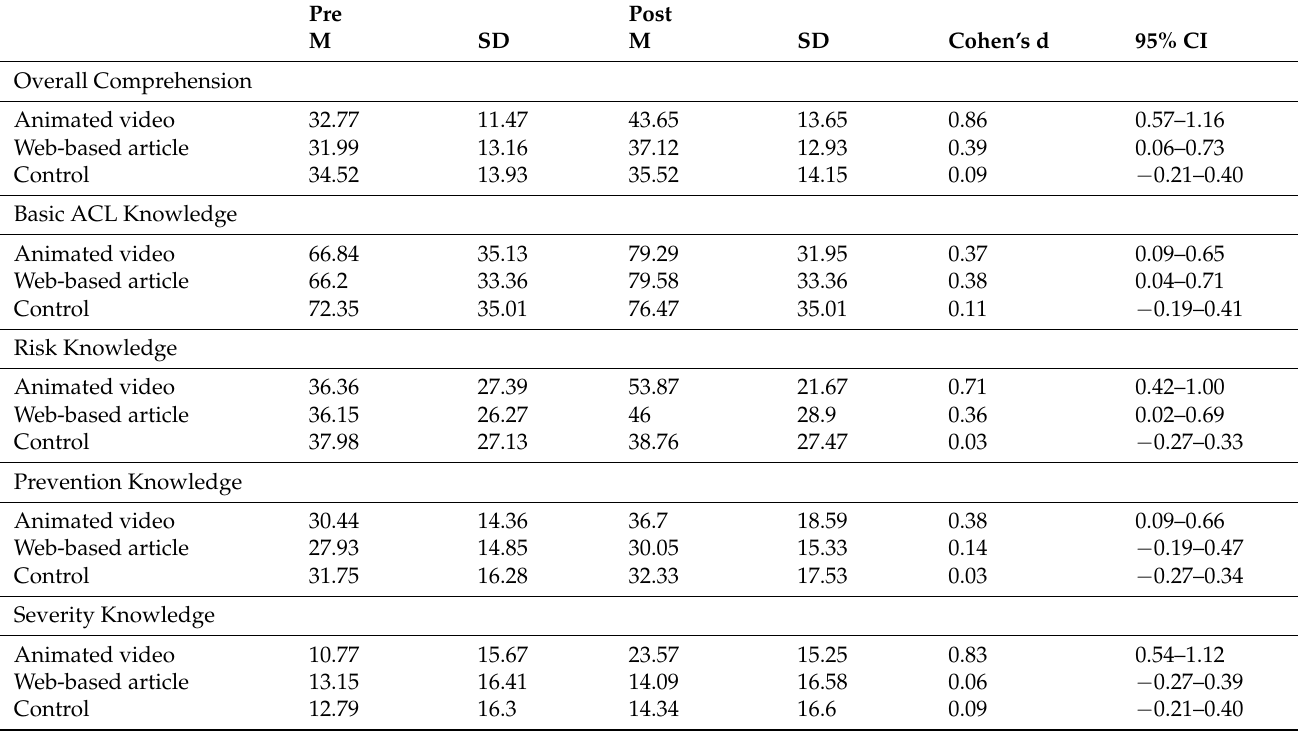
Table 3. Means and standard deviations of percentage correct for each knowledge factor.